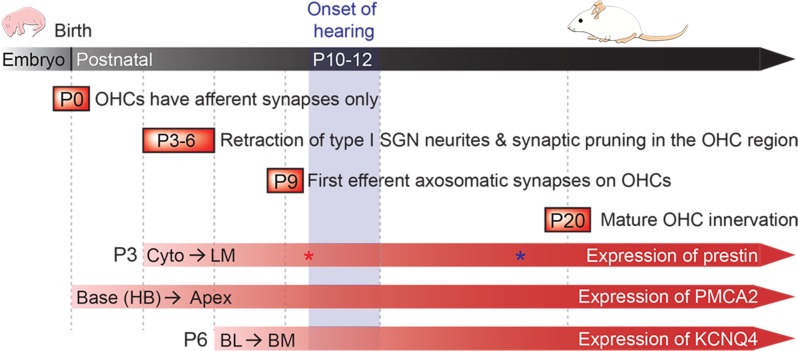
Postnatal development of the cochlea. Developmental milestones are indicated for both afferent and efferent synapses. Prestin protein expression begins around P3 in cytoplasmic vesicles (Cyto), and then moves exclusively to the lateral membrane (LM) (Legendre et al., 2008). Prestin protein expression levels reach a maximum by P10 (shown with red asterisk), while electromotility (NLC) matures by P18 (shown with blue asterisk) (Abe et al., 2007). PMCA2 protein is observed at P0 in hair bundles (HB) at the base of cochlea, and then eventually reaches the apex by P6 (Chen et al., 2012). KCNQ4 proteins are found at the basolateral (BL) membrane by P6, and then quickly localizes to the basal membrane (BM) (Winter et al., 2006). The onset of hearing in mice is around P10–12 (modified from Bulankina and Moser, 2012).